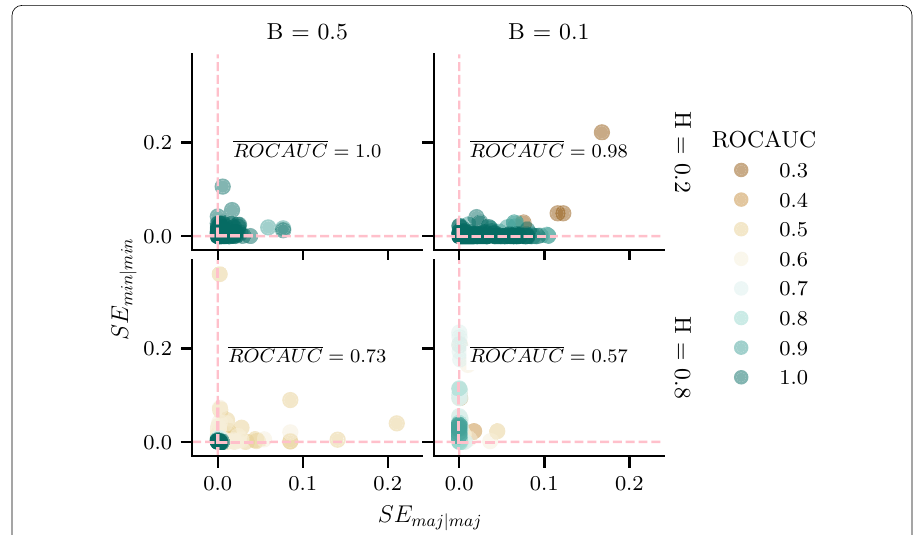
Fig. 3 RQ1: Estimation errors on small samples using random node sampling. These are the squared estimation errors (SE) of the conditional probabilities P maj | maj (x‑axis) and P min | min (y‑axis) learned from small samples ( pseeds ≤ 30% ) using random nodes on sparse networks ( N = 2000, d = 0.004 ) with different levels of homophily (rows) and class balance (columns). Mean ROCAUC scores within each type of network is shown as ROCAUC . In general we see that homophilic networks require lower estimation errors—especially within majorities—to achieve high performance